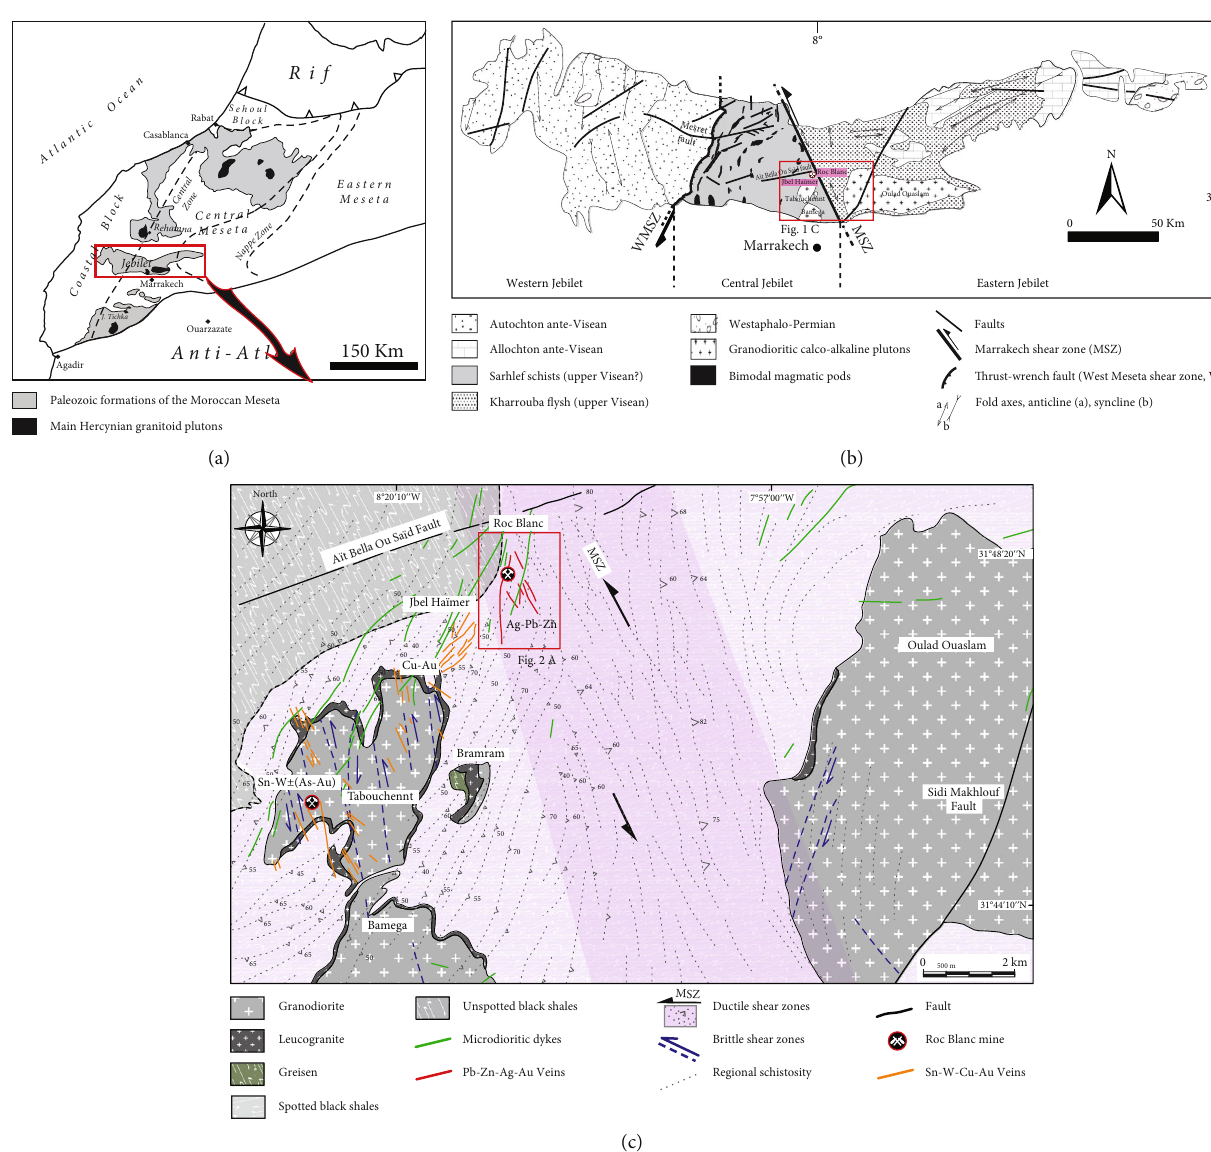
Figure 1: Geological location. (a) Location of the Jebilet massif in the framework of the Palaeozoic outcrops of North Africa. (b) Geological sketch map of the Jebilet massif showing the location of the Roc Blanc deposit (modi fi ed from [22]). (c) Detailed geological map of the south eastern part of the central Jebilet massif